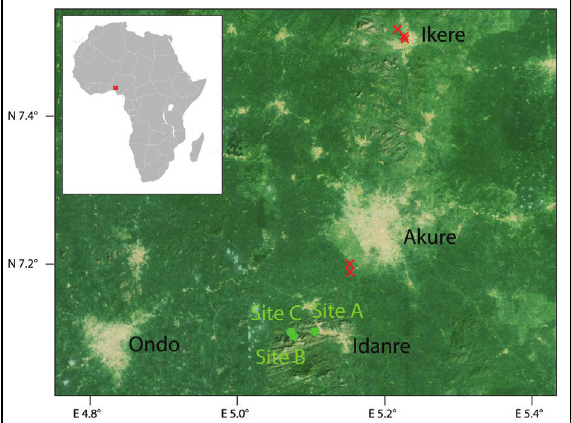
Figure 4. A specimen of the rediscovered Amietophrynus perreti from the type locality, the Idanre Hills, south-western